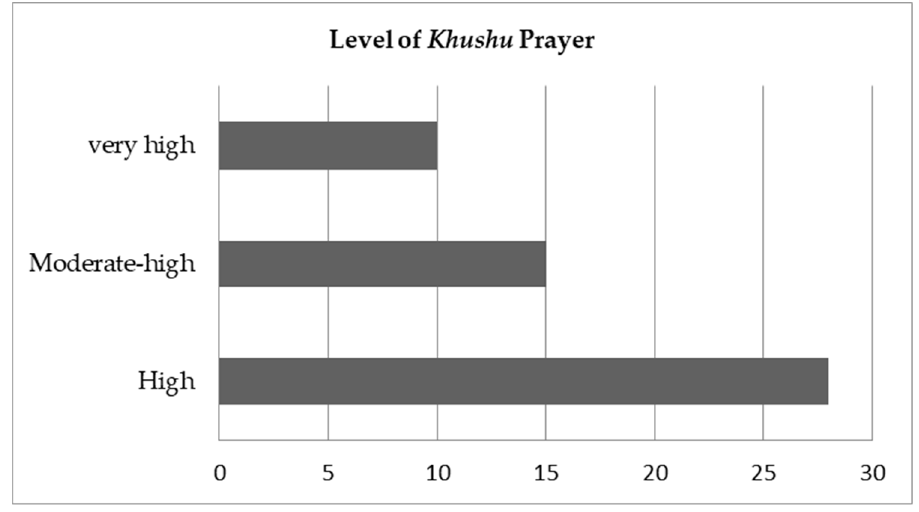
Figure 2. The level of khushu prayer of the participants in the intervention group (n =